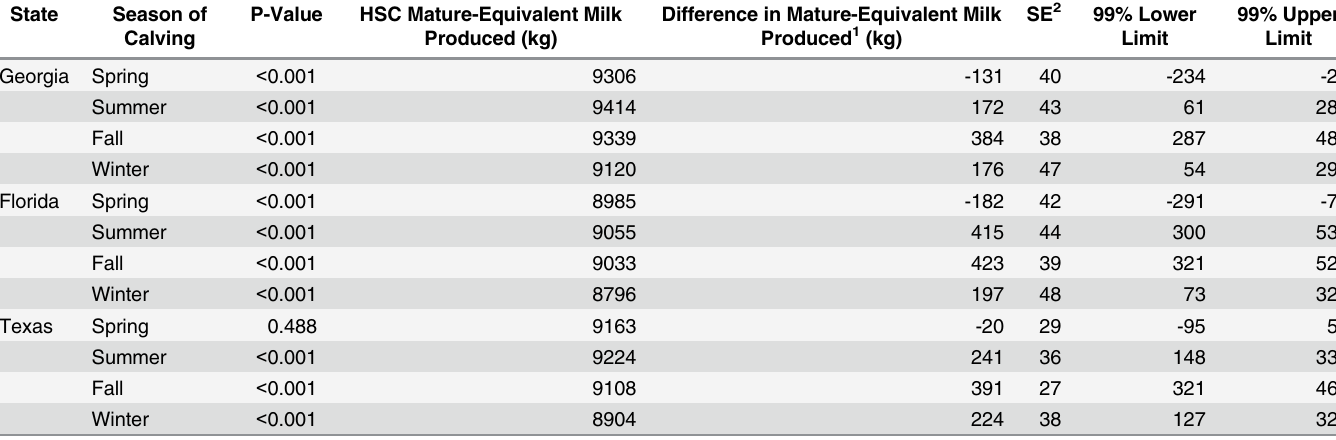
Table 3. Differences in mature-equivalent milk yield between thermoneutral conceived (TNC) and heat stress conceived (HSC) cows in Georgia, Florida and Texas.